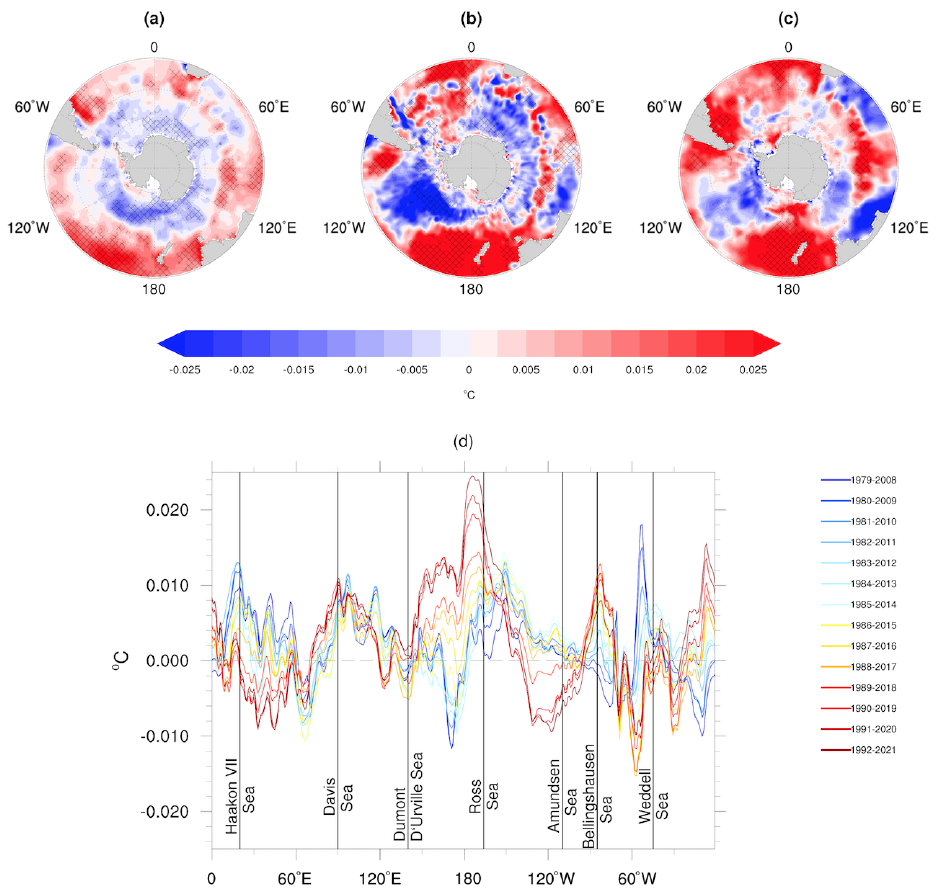
Figure 8. Annual average regression coefficients of Southern Ocean SST between (a) 1979–2021, (b) 1992–2021, and (c) 2007–2021 and (d) 30-year running samples averaged over the region north of the ice edge (55 to 40 ◦ S). Lines are coloured from earliest (1979–2008, dark blue) to most recent (1992–2021, dark red) 30-year SST sample. Vertical lines indicate the approximate mid-point of each geographical location depicted by vertical text. Stippling shows regions where trend patterns are statistically significant ( p < 0 .